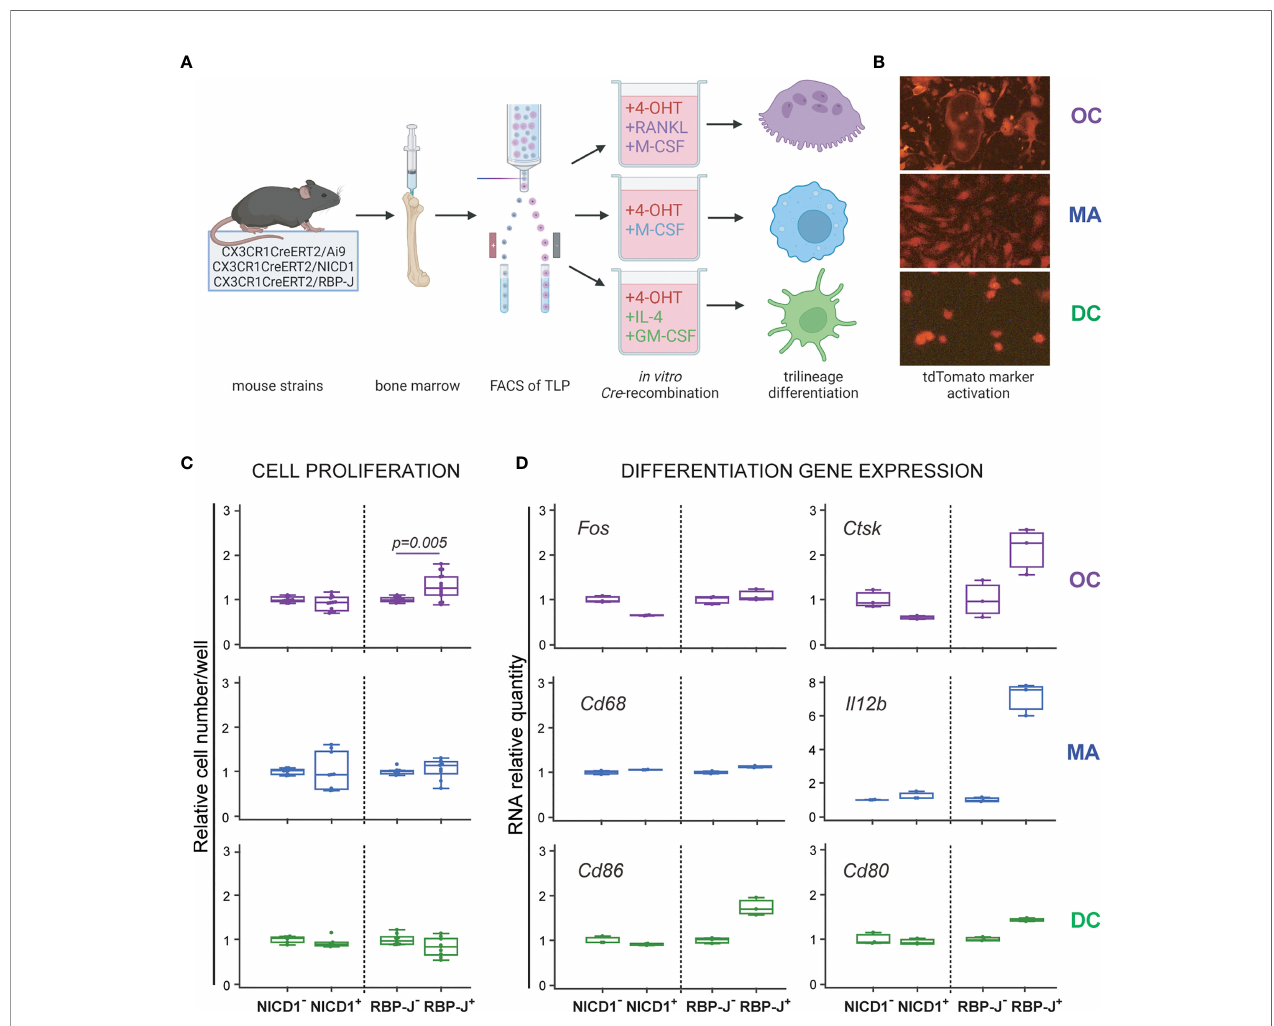
FIGURE 2 | Differentiation potential of the common trilineage progenitor (TLP) isolated from bone marrow cells of CX3CR1CreERT2/Ai9 (Ai9), CX3CR1CreERT2/NICD1 (NICD1) and CX3CR1CreERT2/RBP-J (RBP-J) mice. (A) Experimental design of trilineage differentiation. Bone marrow cells were fl ushed from hind limb long bones and the common TLPs were identi fi ed as CD45 + Ly6G − CD3 − B220 − NK1.1 − CD11b – /lo CD115 + cells using fl ow-cytometry. TLPs were sorted and plated under appropriate culture conditions. Differentiation of osteoclasts (OC) was induced by receptor activator of nuclear factor k B ligand (RANKL) and macrophage colony-stimulating factor (M- CSF); macrophages (MA) by M-CSF; dendritic cells (DC) by interleukin 4 (IL-4) and granulocyte-macrophage colony-stimulating factor (GM-CSF). Cre-mediated recombination in Cre + (NICD1 + or RBP-J + ) littermates was induced by the addition of 4-hydroxytamoxifen (4-OHT). Cre − (NICD1 − or RBP-J − ) littermates treated with 4- OHT were used as controls. Created with BioRender.com (B) Visualization of Cre-mediated recombination by using TLP from CX3CR1CreERT2/Ai9 mice. Representative fl uorescent images show tdTomato + differentiated cells with typical morphology of OCs, MAs and DCs. (C) Quanti fi cation of cells differentiated from NICD1 and RBP-J mice. Cells were differentiated from Cre + and Cre − littermates, fi xed at culture day 3-4, stained and quanti fi ed using CellPro fi ler. Cell numbers were normalized to the appropriate Cre − control in each experiment; pooled data from three independent experiments are shown (n=9-12). Statistically signi fi cant difference was determined at p<0.05 between corresponding Cre + and Cre − groups, Mann – Whitney U-test. (D) qPCR analysis of differentiation gene expression for OCs ( Fos , Ctsk ), MAs ( Cd68 , Il12b ) and DCs ( Cd86 , Cd80 ). Cells were harvested at culture day 3 for RNA isolation. Gene expression was normalized using Hmbs housekeeping gene and presented as relative gene expression normalized to the appropriate Cre − control; technical replicates for the representative experiment are shown (n=3). Expression difference of approximately 2-fold is considered biologically signi fi cant. (C , D) Individual values are presented; horizontal lines represent the median, boxes represent the interquartile range (IQR), whiskers represent 1.5 times the